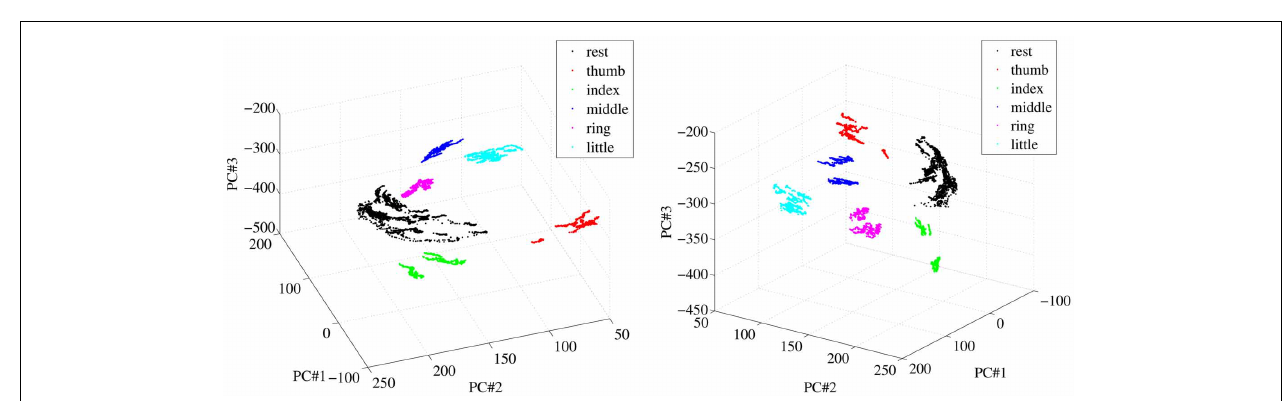
FIGURE 6 | Two different views of a three-dimensional PCA projection of the samples obtained from a typical subject during OO1 and OO2. Colors denote finger flexions and rest.